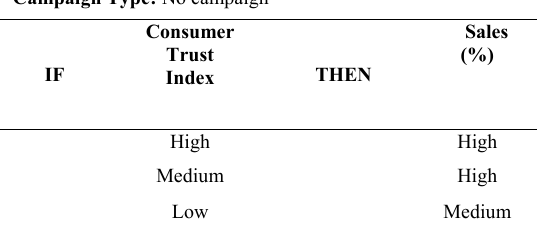
Table 3. Fuzzy rule base for “no campaign” status